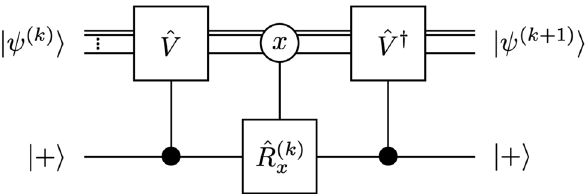
Figure 2. Quantum circuit interpretation of the maximum likelihood iteration. The solid dot indicates the “controlled”- ˆ V (or ˆ V † ) acting only when the pointer is in the state “conditional”- ˆ R x on the pointer conditioned on the state interpretation, the iteration procedure is not linear as the operator ˆ R x